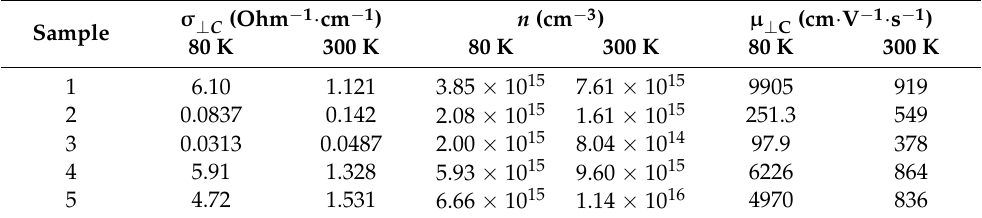
Table 1. Electrical parameters along the layers of different n -InSe